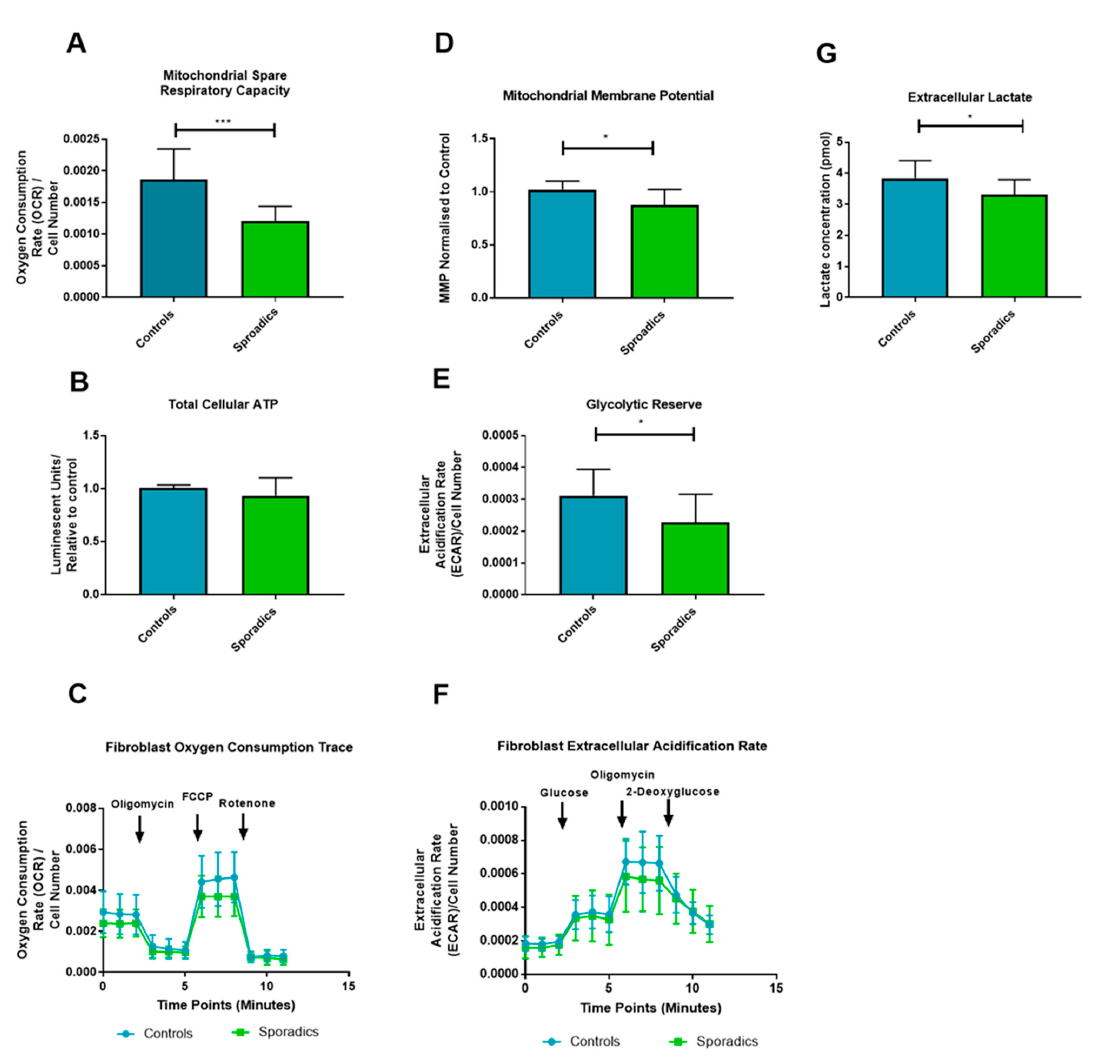
Figure 2. Oxidative phosphorylation and Glycolytic fibroblast Assessment: *** = p < 0.001; * = p < 0.05. Significant reductions in mitochondrial spare respiratory capacity ( A ), Mitochondrial Membrane potential ( D ), Glycolytic Reserve ( E ) and Extracellular lactate ( G ) was detected in sAD when compared to controls. No significant di ff erence was seen in total cellular ATP ( B ). OCR and ECAR traces for mitochondrial stress test and glycolysis stress test are displayed in panels ( C ) and ( F ) respectively. For all panels controls are represented in blue and sAD are represented in green. Graphs represent mean with error bars indicating standard deviation.